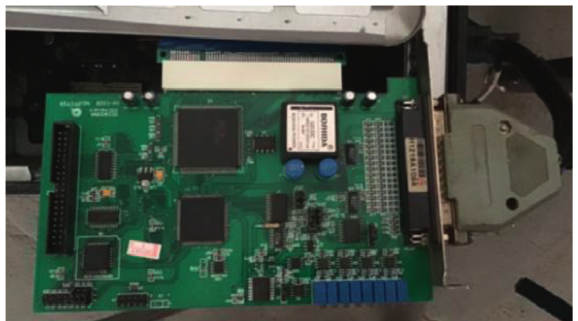
Figure 9: PCI8335A acquisition card.